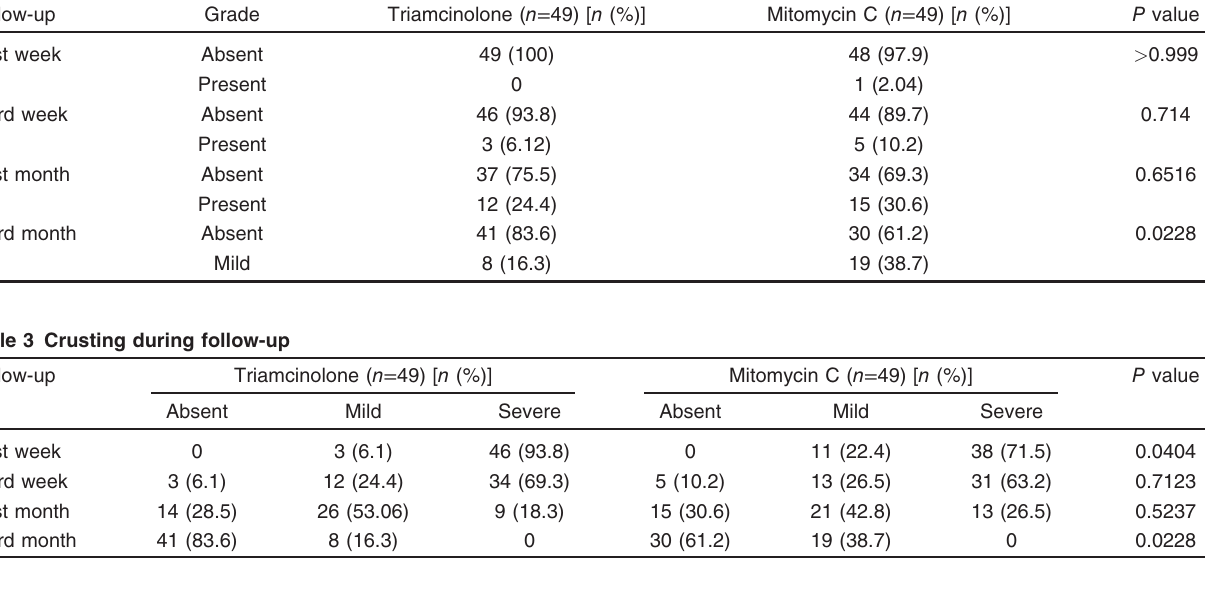
Table 4 Symptoms at third week of follow-up Table 5 Ostial patency on